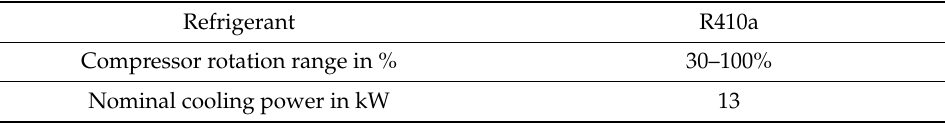
Table A2. Compression heat pump.